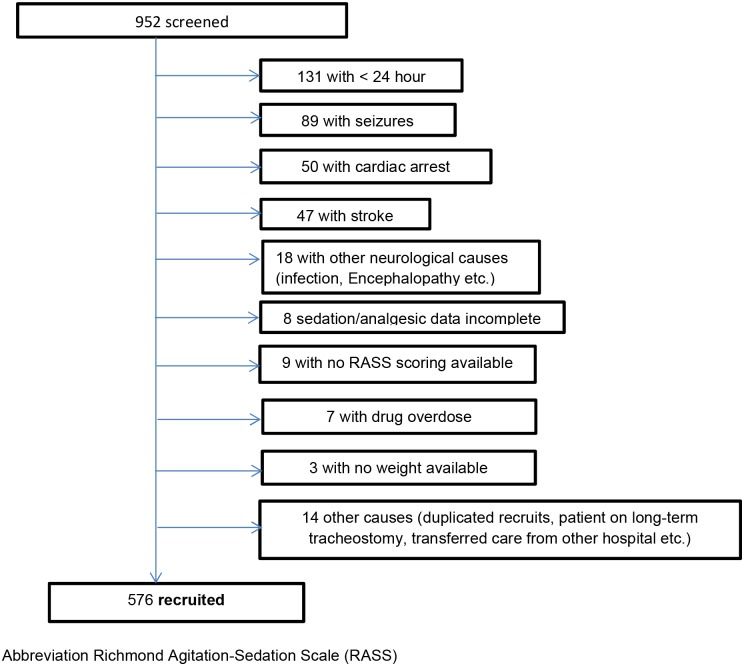
Flowchart showing patient inclusion in the study.